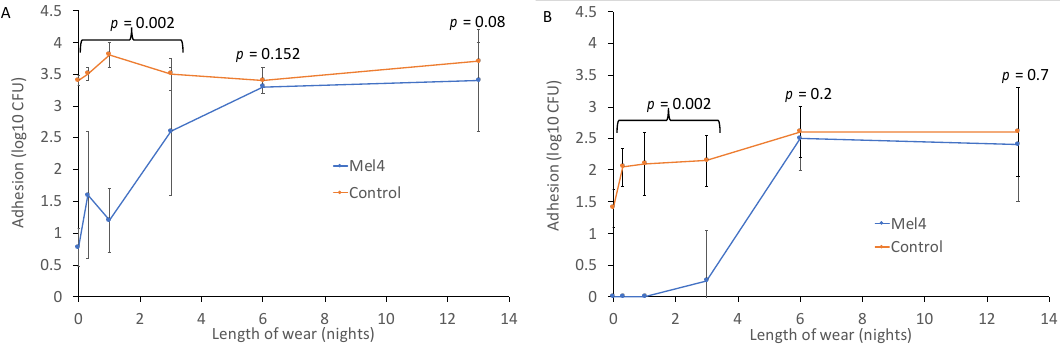
Figure 1. Bacterial adhesion to Mel4-coated and control contact lenses worn for up to 13 nights for ( A ) P. aeruginosa and ( B ) S. aureus .